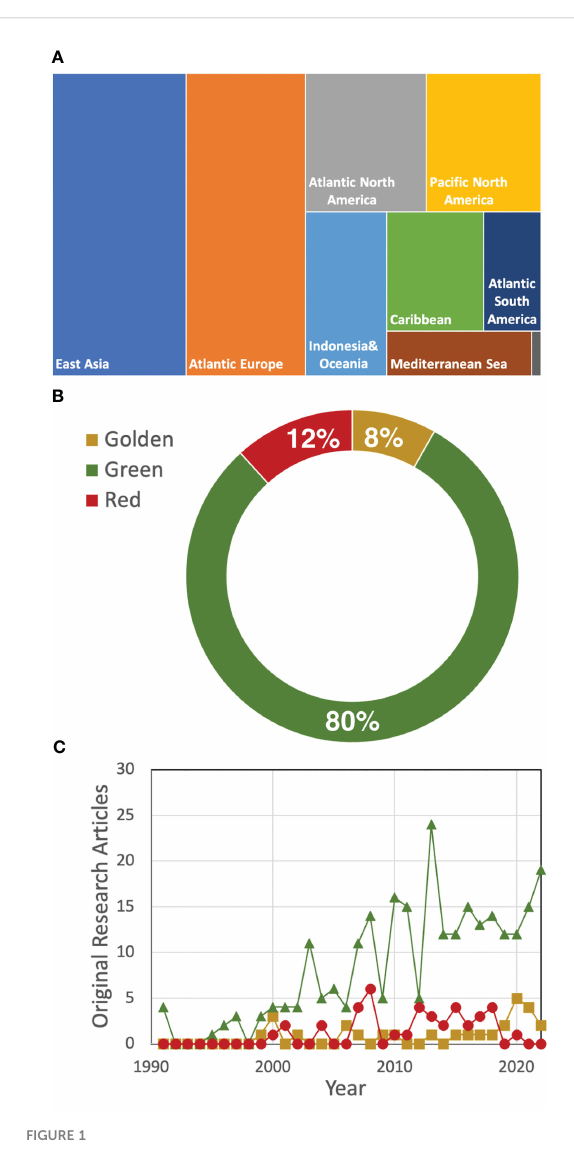
FIGURE 1 Number of mentions in eligible original research articles found in SCOPUS sorted by geographical region -the area is proportional to the number of mentions- (A) , type of macroalgal bloom (B) , and by type of bloom (green-triangles; golden-circles; red -squares) and year (C) . In total, 265 original research articles published until 2022 were considered in the analysis.